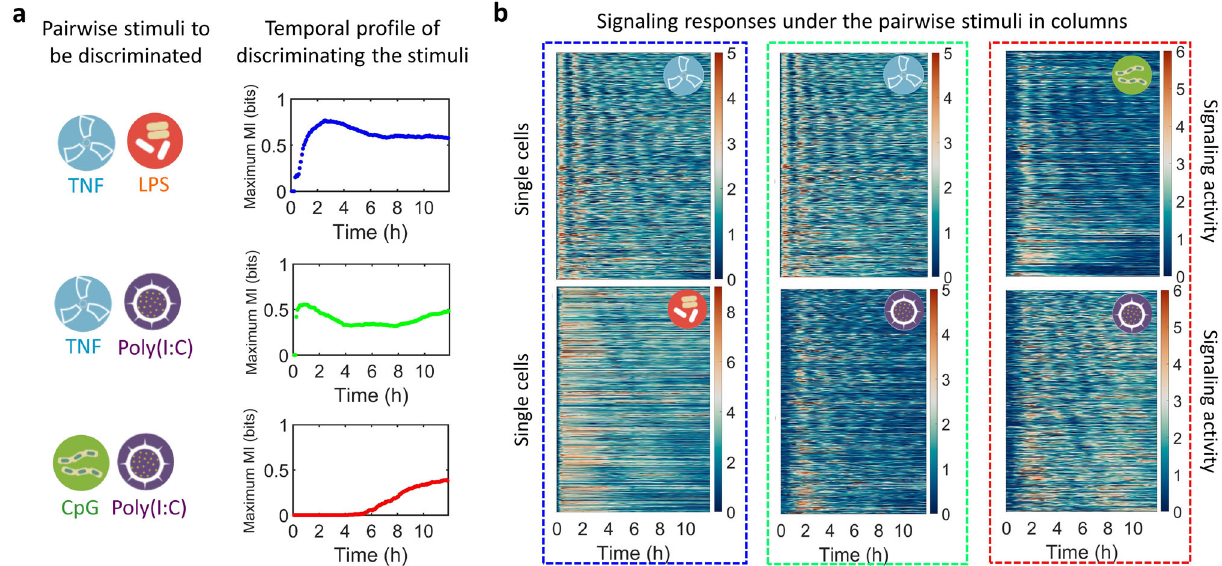
Fig. 4 Pairwise stimuli distinction occurs in different temporal orders. a The maximum dMI for three pairs of stimulus conditions chosen from the dataset in Fig. 2: 10 ng/ml TNF and 100 ng/ml LPS (blue); 10 ng/ml TNF and 10 μ g/ml Poly(I:C) (green); 100 nM CpG and 100 ng/ml Poly(I:C) (red). b The heatmaps of the NF κ B response for the corresponding stimuli pairs grouped in columns. The time regime with relatively distinct dynamical patterns corresponds to the high maximum dMI in ( a ). Source data are provided as a Source Data fi transmission were revealed (Fig. 4a): (1) an early increase with sustained high MI (TNF vs LPS); (2) a rapid early increase with a drop in the intermediate phase (TNF vs Poly(I:C)); and (3) a late accumulation (Poly(I:C) vs CpG).